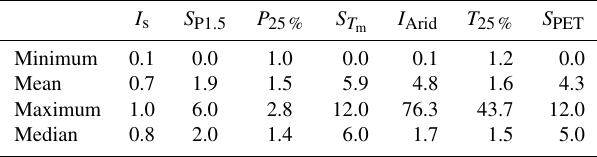
Table 4. Statistical summaries of the PCA-selected grid-based cli- matic indices using WorldClim-2 monthly